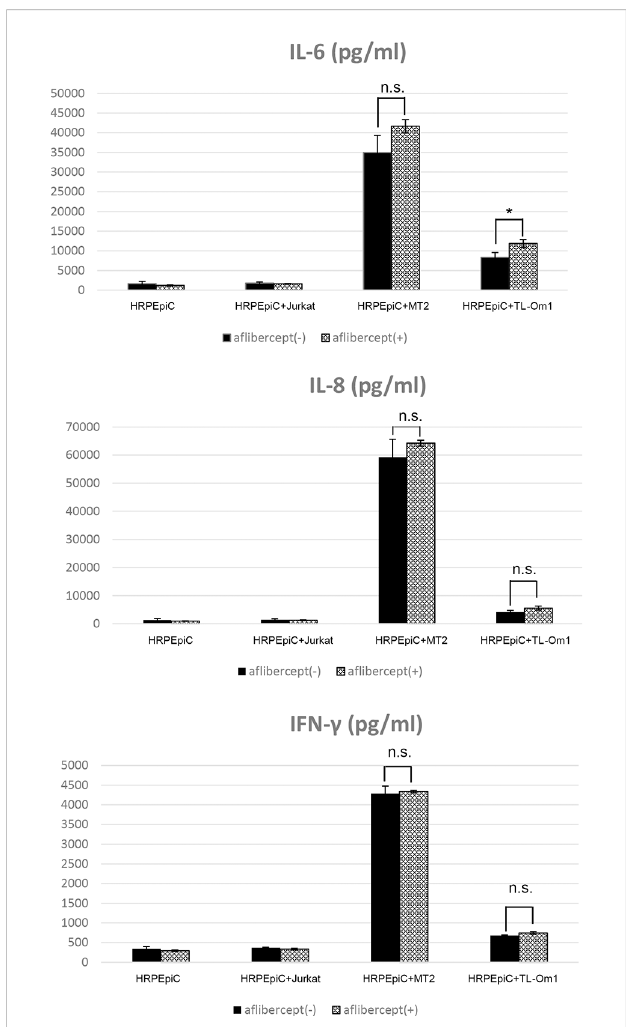
FIGURE 3 Levels of in fl ammatory cytokines were measured in the culture supernatants of HRPEpiCs and HRPEpiCs co-cultured for 48 h with MT2, TL-Om1, or Jurkat cells with/without 0.5 mg/mL a fl ibercept. In co-culture of HRPEpiCs with MT2 cells, a fl ibercept did not signi fi cantly affect the levels of IL-6, IL-8, and IFN- g . In co-culture of HRPEpiCs with TL-Om1 cells, production of IL-6 increased signi fi cantly following a fl ibercept addition, but levels of IL-8 and IFN- g did not change signi fi cantly. Data are taken from three independent biological experiments and presented as the mean ± SEM (units: pg/ m L) (*P < 0.05; n.s., not signi fi